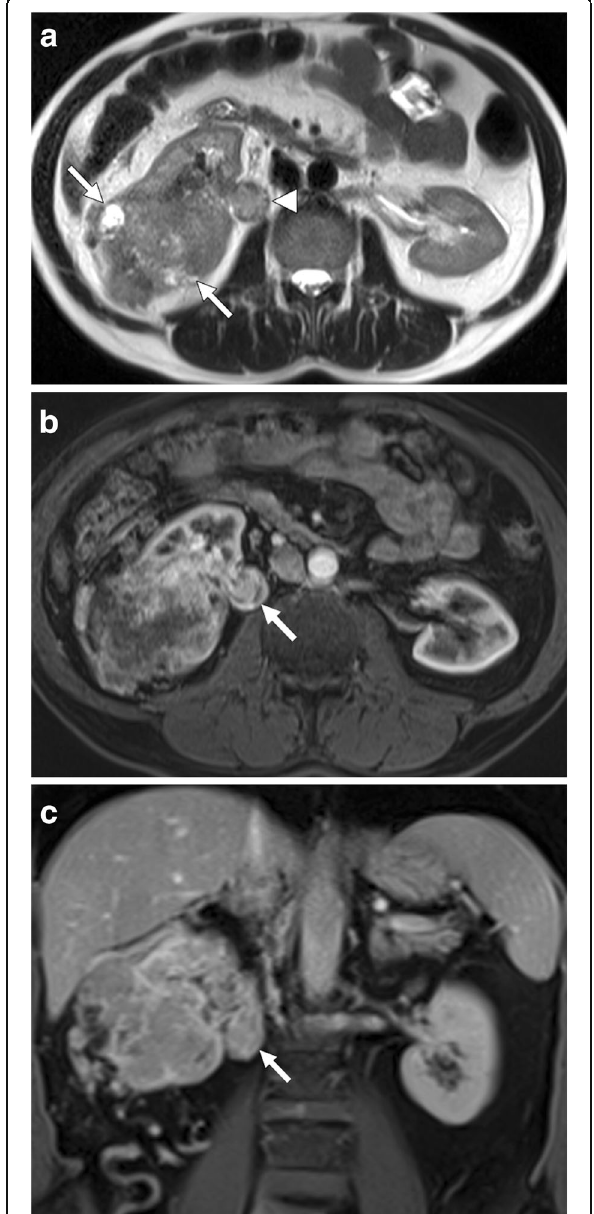
Fig. 14 A 67-year-old male with no past medical history presented with right flank pain and hematuria. US study showed a large infiltrative mass filling right perirenal space. a Axial plane T2W MR image demonstrates a solid mass with heterogeneous signal intensity infiltrating the right kidney (arrows). Also, note is made of the expanded right testicular vein filled with thrombus (arrowhead) having a similar signal texture with the primary mass concerning for a tumoral thrombus over a bland thrombus. Axial ( b ) and coronal ( c ) plane postcontrast T1W MR images show enhancement within the thrombus (arrow) confirming its tumoral nature. Histopathological examination after surgical resection revealed primary RCC and tumoral thrombus within the testicular